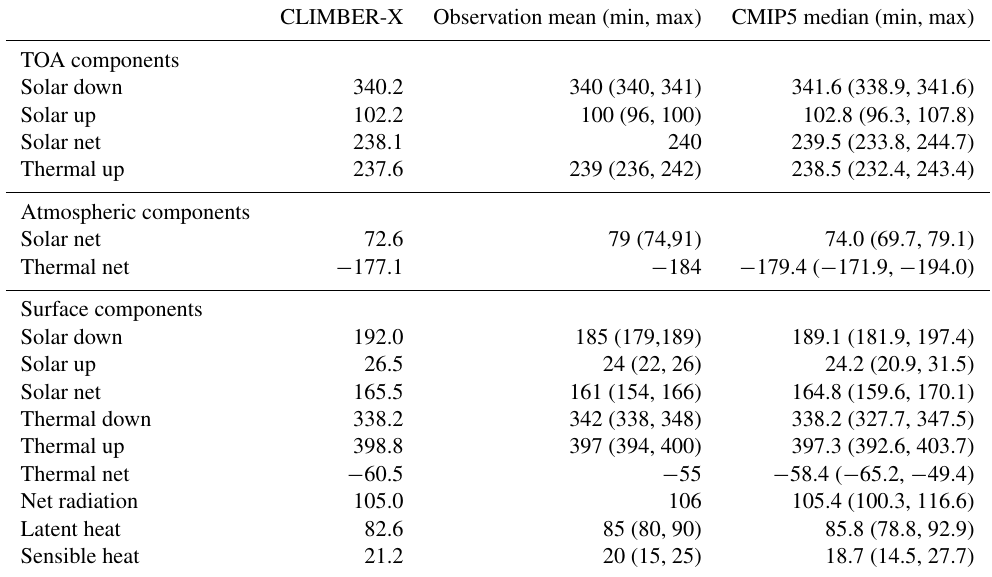
Table 1. Earth’s radiation and energy budget in CLIMBER-X compared to observations and CMIP5 models from Wild et al. (2013). The unit is Wm − 2 .